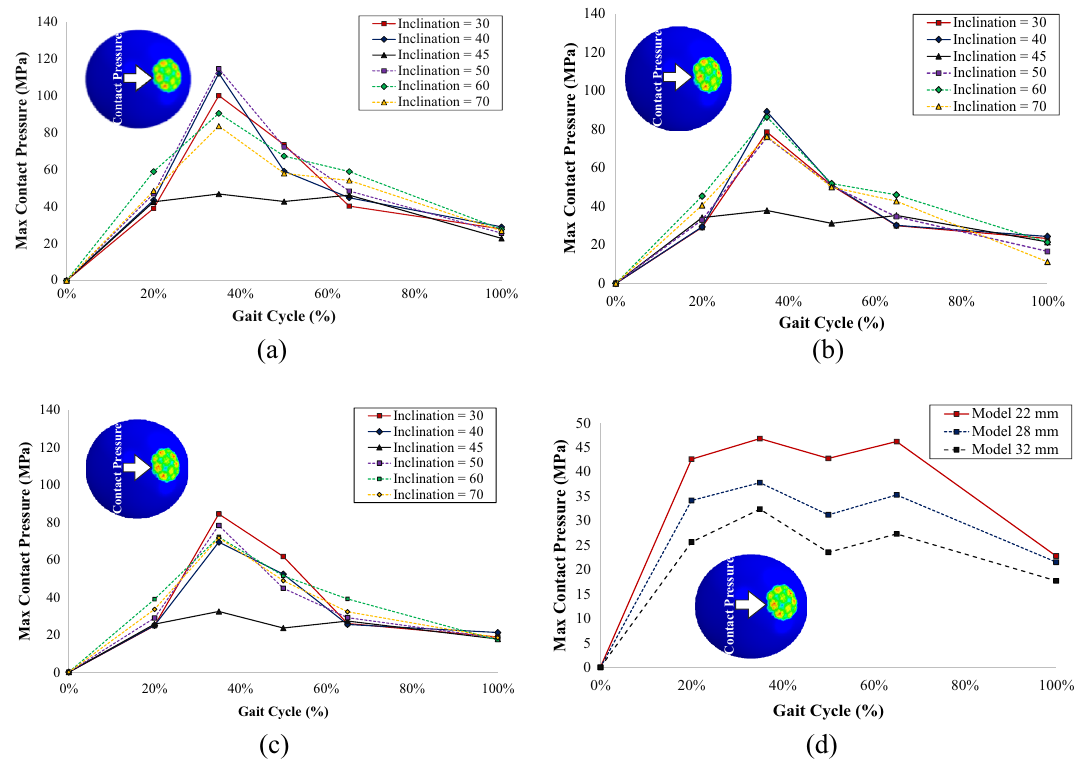
Figure 7. Contact pressure on the outer surface of the outer liner: ( a ) model with a 22 mm femoral head, ( b ) model with a 28 mm femoral head, ( c ) model with a 32 mm femoral head, ( d ) contact pressure comparison of different head diameters at 45° inclination